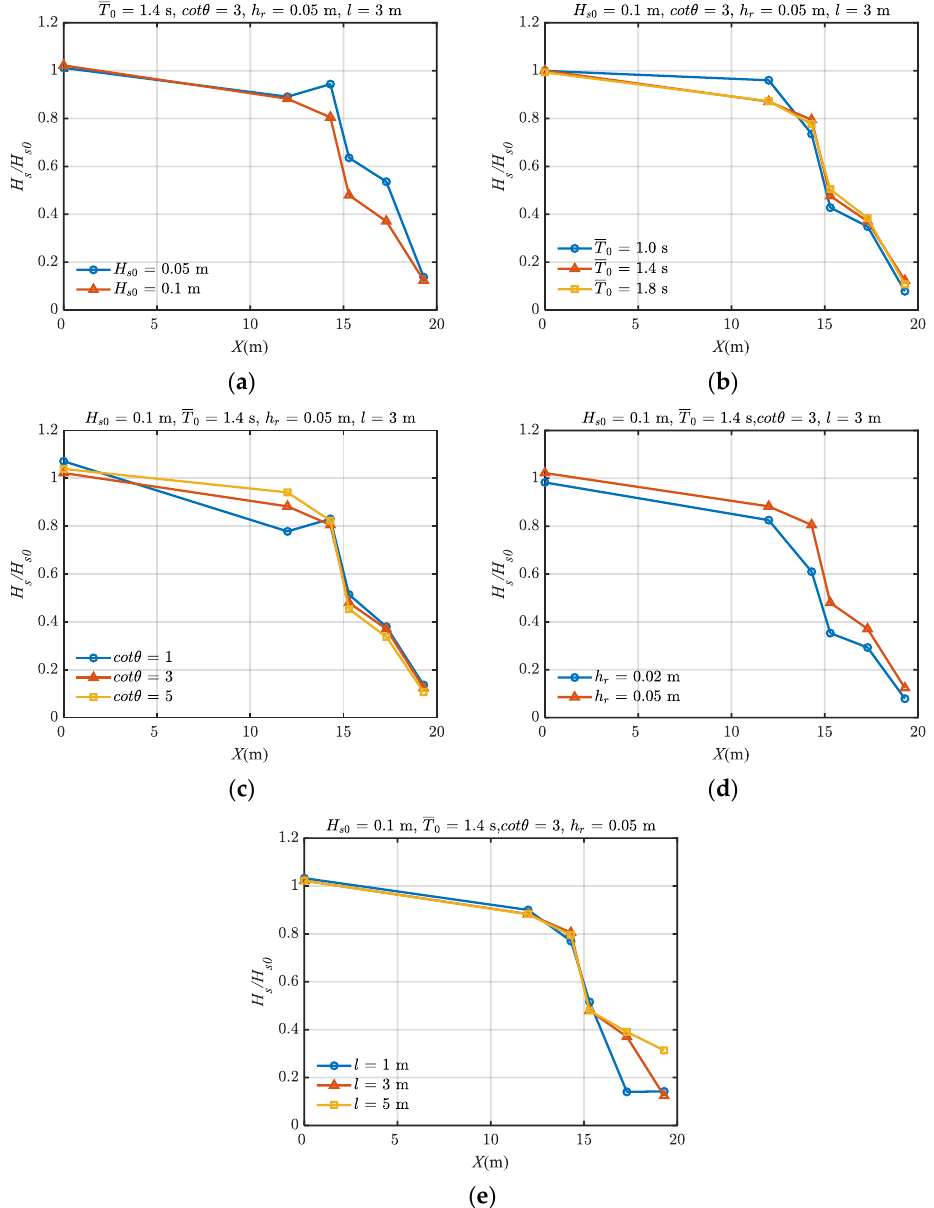
Figure 13. Irregular wave height transformation for the sloped seawall for different cases: ( a ) H s 0 ; ( b ) T 0 ; ( c ) cot θ ; ( d ) h r ; ( e ) l 0 Figure 14 shows the irregular wave spectra across the reef topography with and with- out the vertical and sloped seawalls. The frequency spectrum of irregular waves was ob- tained by using the Fast Fourier Transform (FFT) at different locations G1–G6 along the wave propagation direction. The power spectra generally behave similarly for the vertical and sloped seawalls. The wave energy is significantly reduced during the wave run up on the fore reef slope at G2 and is further weakened from G3 to G5 in the wave surf zone on the reef flat. The high frequency waves are gradually attenuated during wave propaga- tion, while the infragravity waves with low frequency (0.028 Hz < f < 0.28 Hz in this ex- periment) gradually become dominant on the reef flat topography (G4–G5). Similar re- sults were also observed by Nwogu and Demirbilek (2010), in that the infragravity wave energy increased as the wave was propagated over the reef flat. It is notable that the wave